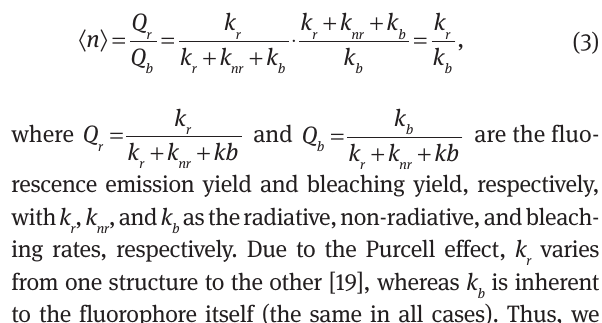
Figure 3: Simulated rate dependencies. (A) Normalized radiative decay rate as a function of wavelength and NP oxidation level. Black dashed line renders the contour k (B) Spectrally averaged decay rate as a function of oxidation level for monomers (grey) and dimers (black). (C) Radiative decay for both axial (dark blue) and normal (red) fluorophore orientations for non-oxidized (dashed lines) and oxidized (solid lines) dimers. The inset shows a sketch of the OA geometry. (D) Radiative and non-radiative decay rate for four different fluorophore positions (colors, see inset) within the DNA origami between an oxidized NP